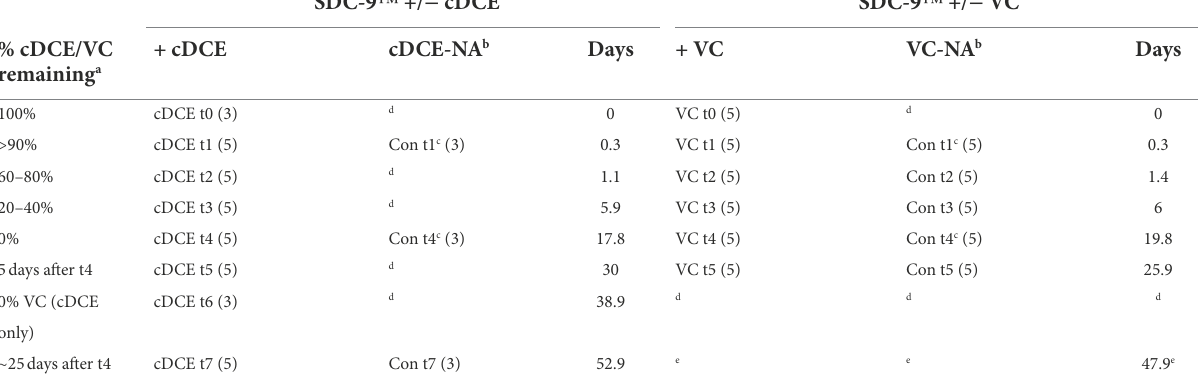
TABLE 1 Time points of sample collection during growth of SDC-9 ™ with either cDCE or